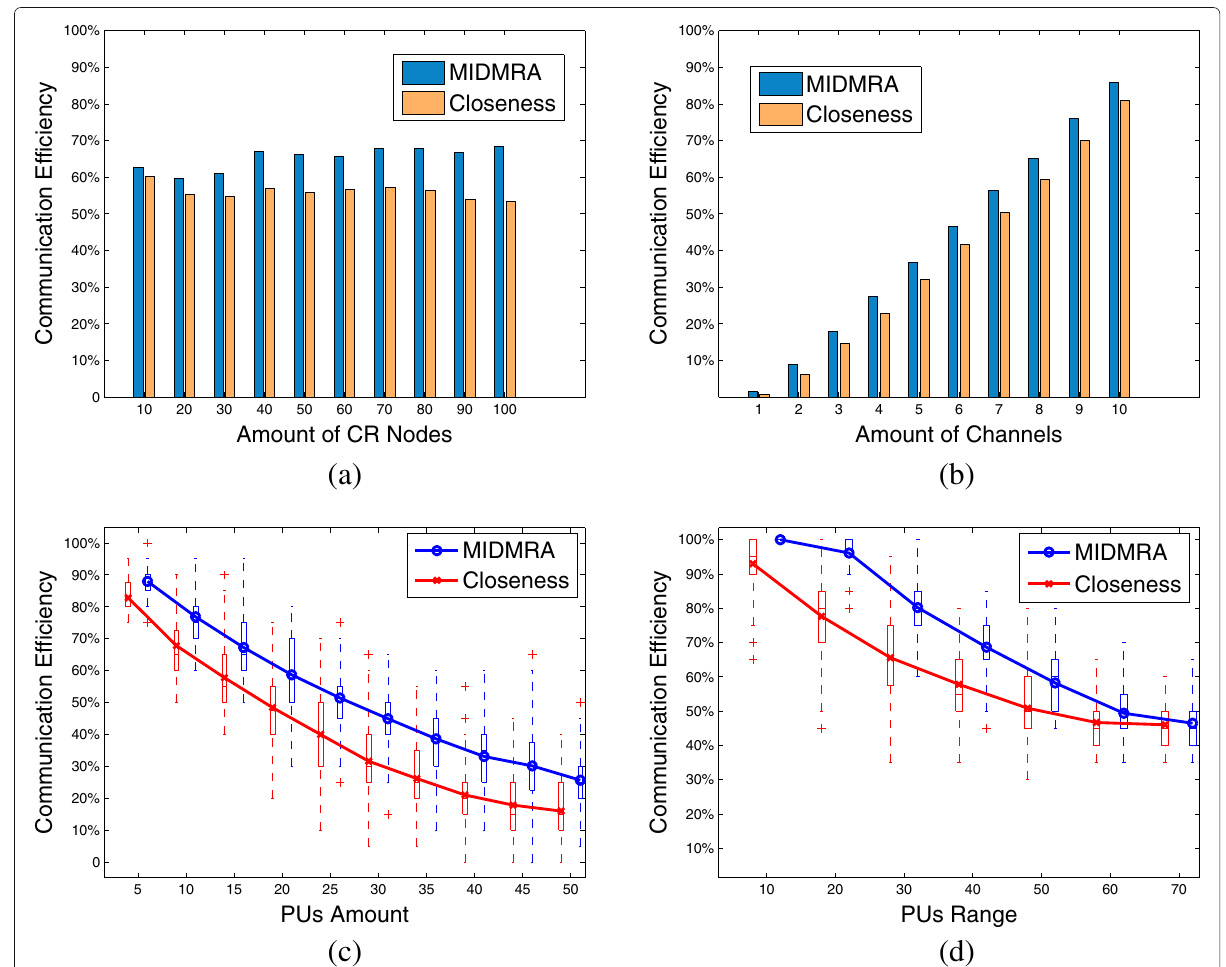
Fig. 6 Communication efficiency comparison. a Variation with CR nodes. b Variation with channels. c Variation with PUs amounts. d Variation with PUs ranges